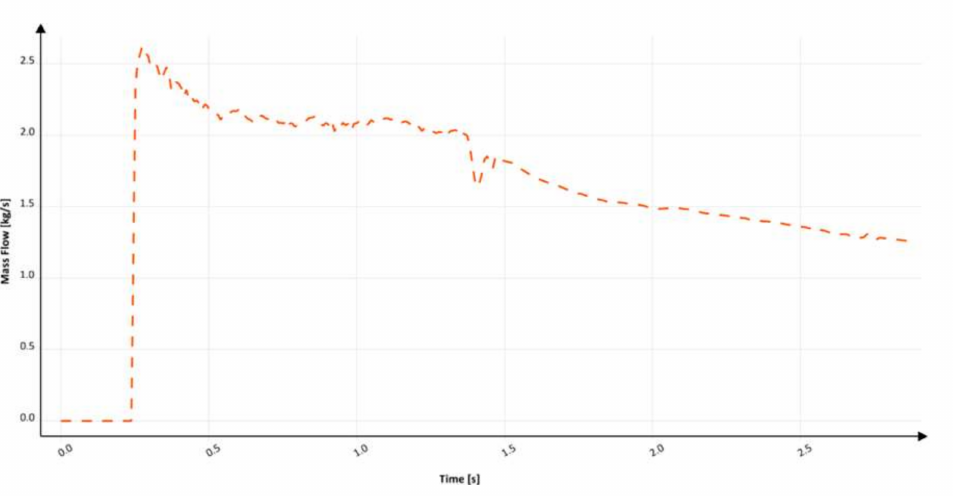
Figure 27. Mass flow through ingate with round sprue with straight taper (S s 5),